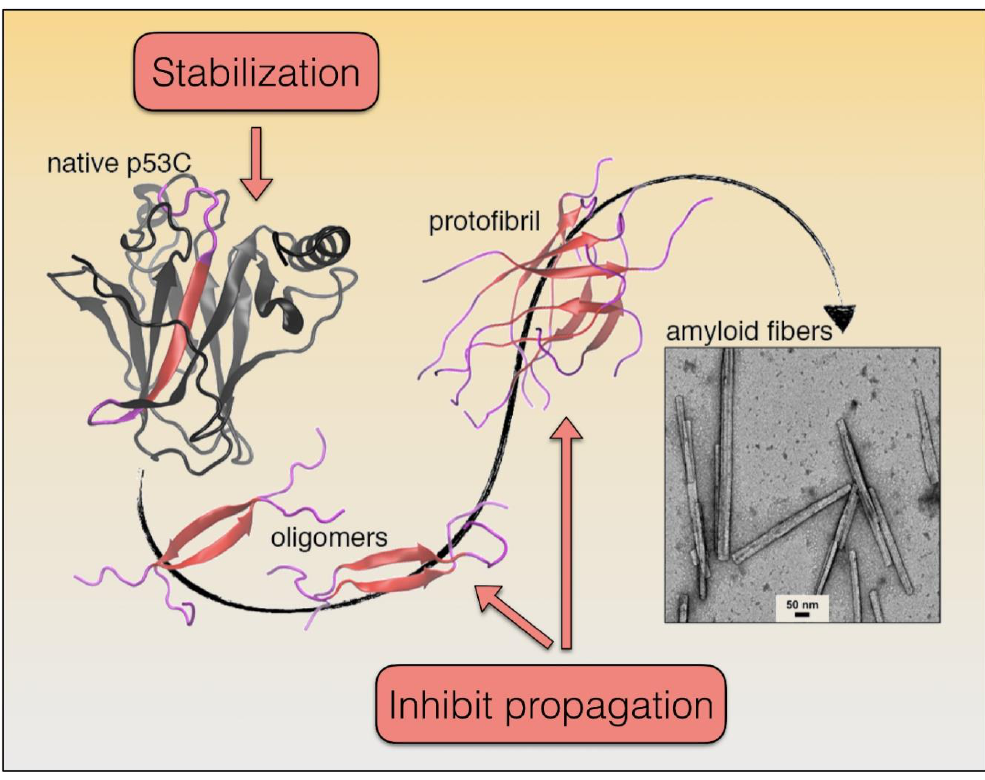
Figure 4. Illustration of p53 aggregation. The scheme shows a potential route of p53 amyloid aggregation and potential avenues of inhibition based upon molecular dynamic simulations and electron microscopy experiments [85].